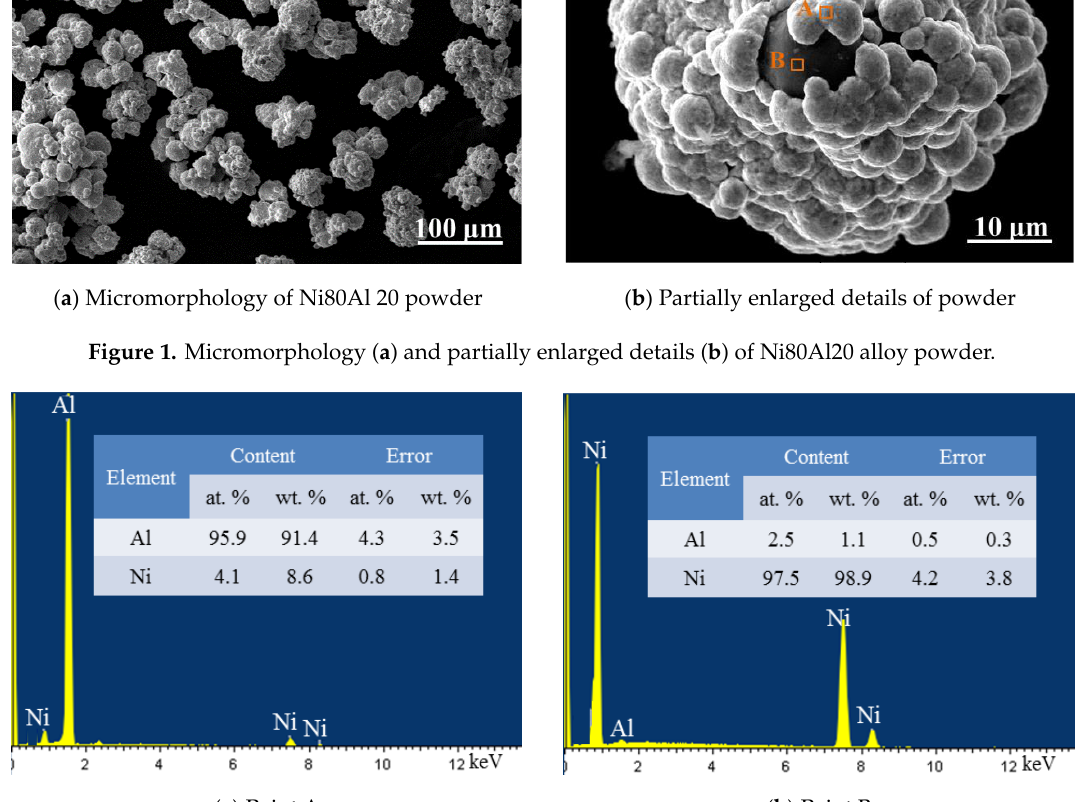
Figure 2. EDS element contents analysis for different parts ( a ) Point A and ( b ) Point B in Figure 1b.